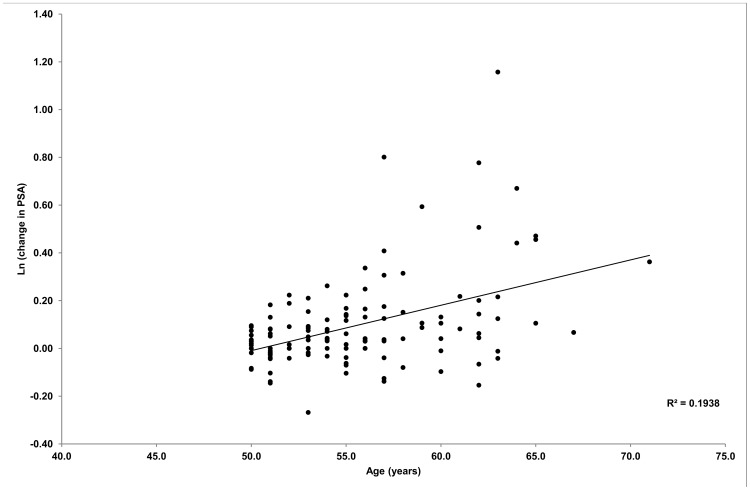
Univariate linear regression of age vs tPSA change (log transformed).